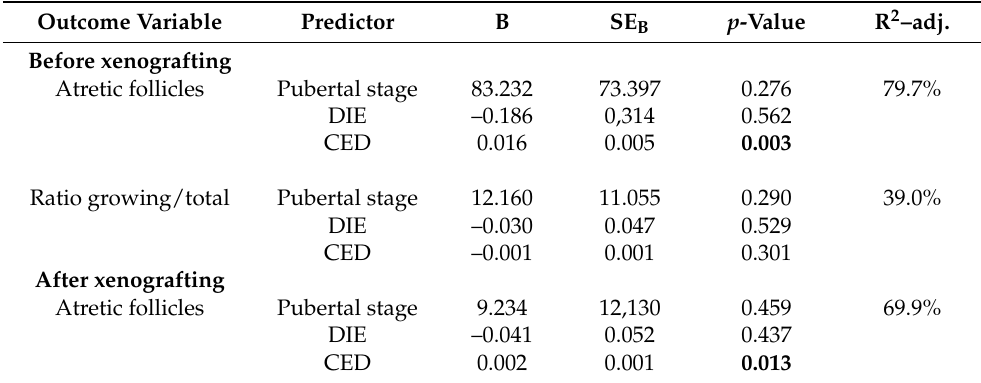
Table 4. Multivariate-linear-regression analysis of atretic follicle numbers per graft and ratio